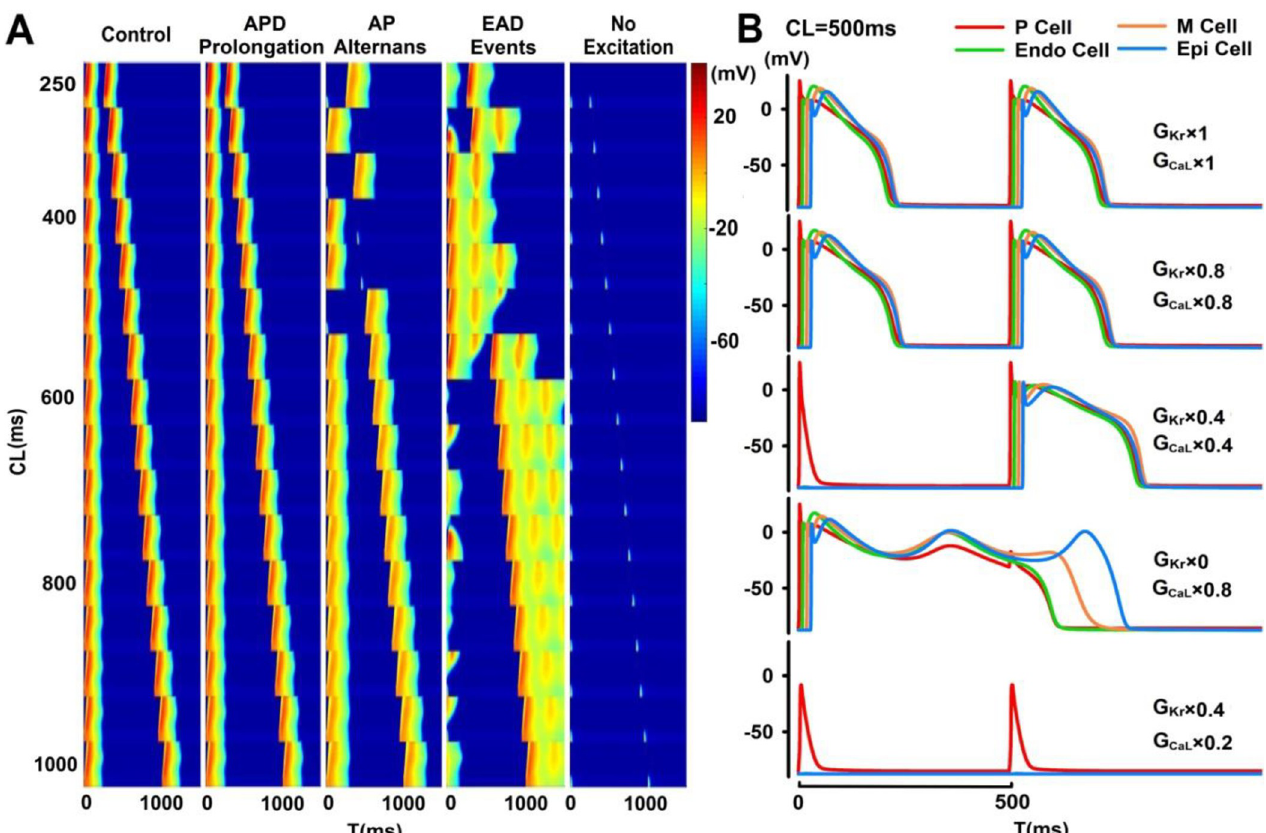
Fig 3. (A) Representative groups of simulations of the PVS tissue model with minor changes, AP alternans, EAD events or no excitation, where the group of simulations were visualized as a stack of 16 spatiotemporal maps with pacing CLs ranging from 250 ms (top) to 1000 ms (bottom). (B) Representative AP morphologies of each cell type at CL = 500 ms under control (top) and pathological